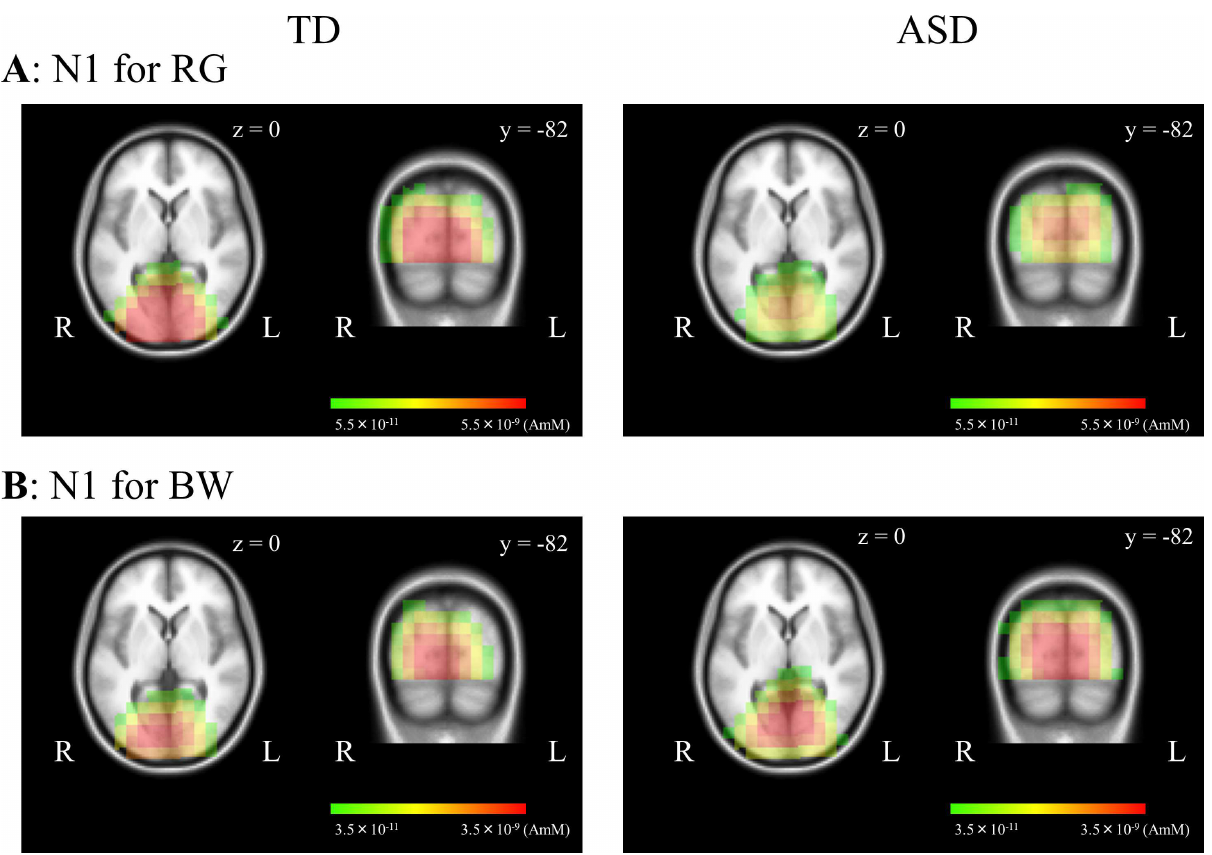
Fig 5. Source analysis for VEPs with RG and BW stimuli in each group. sLORETA activities were mappedonto the MNI space. N1 componentsfor RG (A) and BW (B) stimuli were located at aroundoccipitalareas including V1 in both groups. sLORETA , standardized low resolutionbrain electromagnetic tomography; MNI , MontrealNeurological